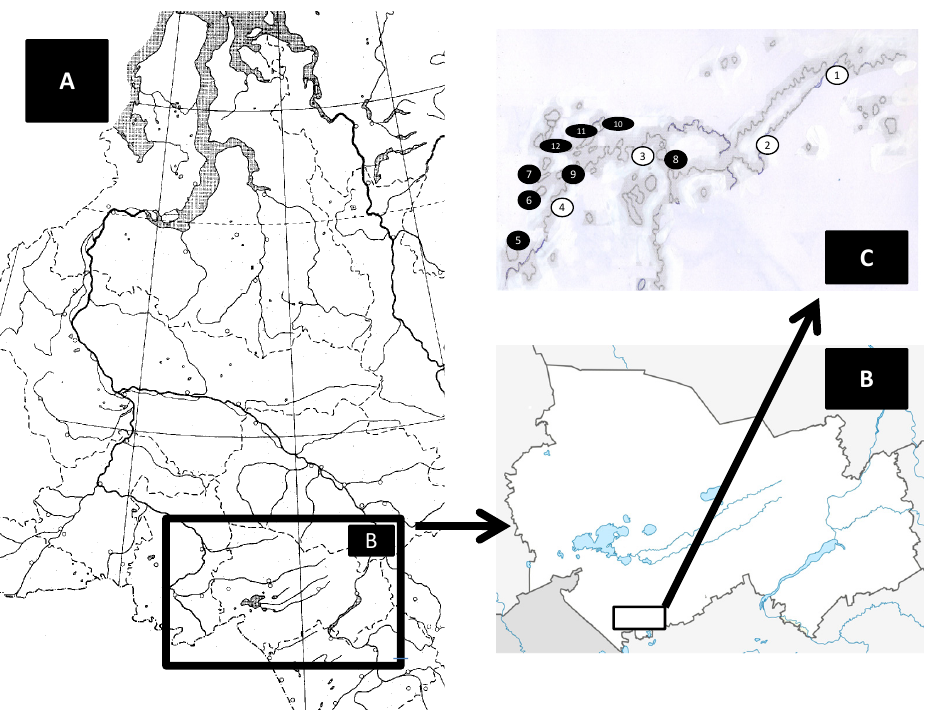
Figure 1. Sampling sites of examined gastropod snails in water bodies of Northern Kulunda. ( A ) Western Siberia. ( B ) Novosibirsk region. ( C ) Water bodies of Northern Kulunda: Karasuk River, upstream near Bystrukha village (1); Karasuk River, upstream near Tchernovka village (2); Karasuk River, downstream near Gramotino village (3); Karasuk River, downstream Sorochikha village (4); Lake Astrodym (5); Lake Krotovo (6); Lake Kusgan (7); Lake Melkoye (8); Lake Titovo (9); Lake Krivoye—reach Blagodatnoye (10); Lake Krivoye—reach Sopatoye (11); Lake Krivoye—reach Gusinoye (12).